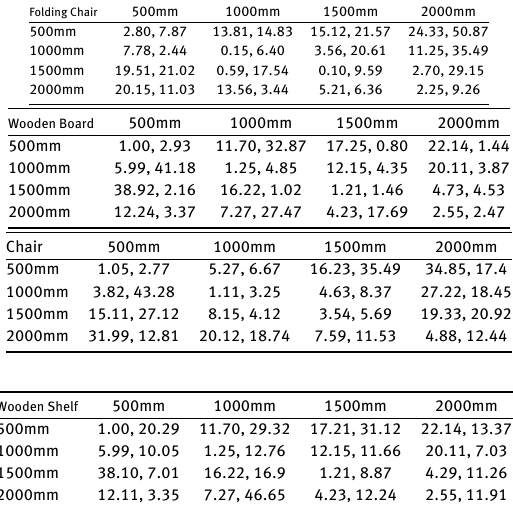
Table 2: Precision on detection results was investigated. Top rows indicate distances between a sensor and an object on a model- ing process, whereas leftmost columns show the distances on a detection process. First numerical value in each cell shows a dis- tance [mm] between average detected position and ground truth (= Accuracy), and second value shows the standard deviation of the detected position [mm] from average (= Precision). Accuracy and precision was high when the distances are the same at the mod- eling and the detection process. In most other cases, the possible error was several tens of millimeters.